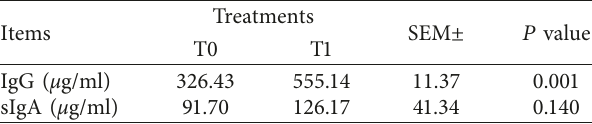
Table 4: Effect of the mixed powder of leaves of plants with medicinal properties on IgG and sIgA serum concentration.